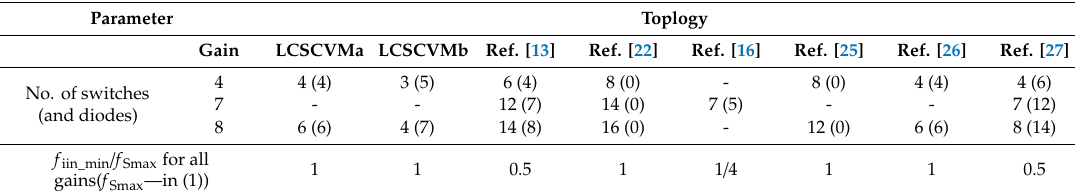
Table 4. Comparison of the number of switches and diodes, and the lowest frequency of the input current in selected topologies versus the voltage gain. Ref. = Reference.